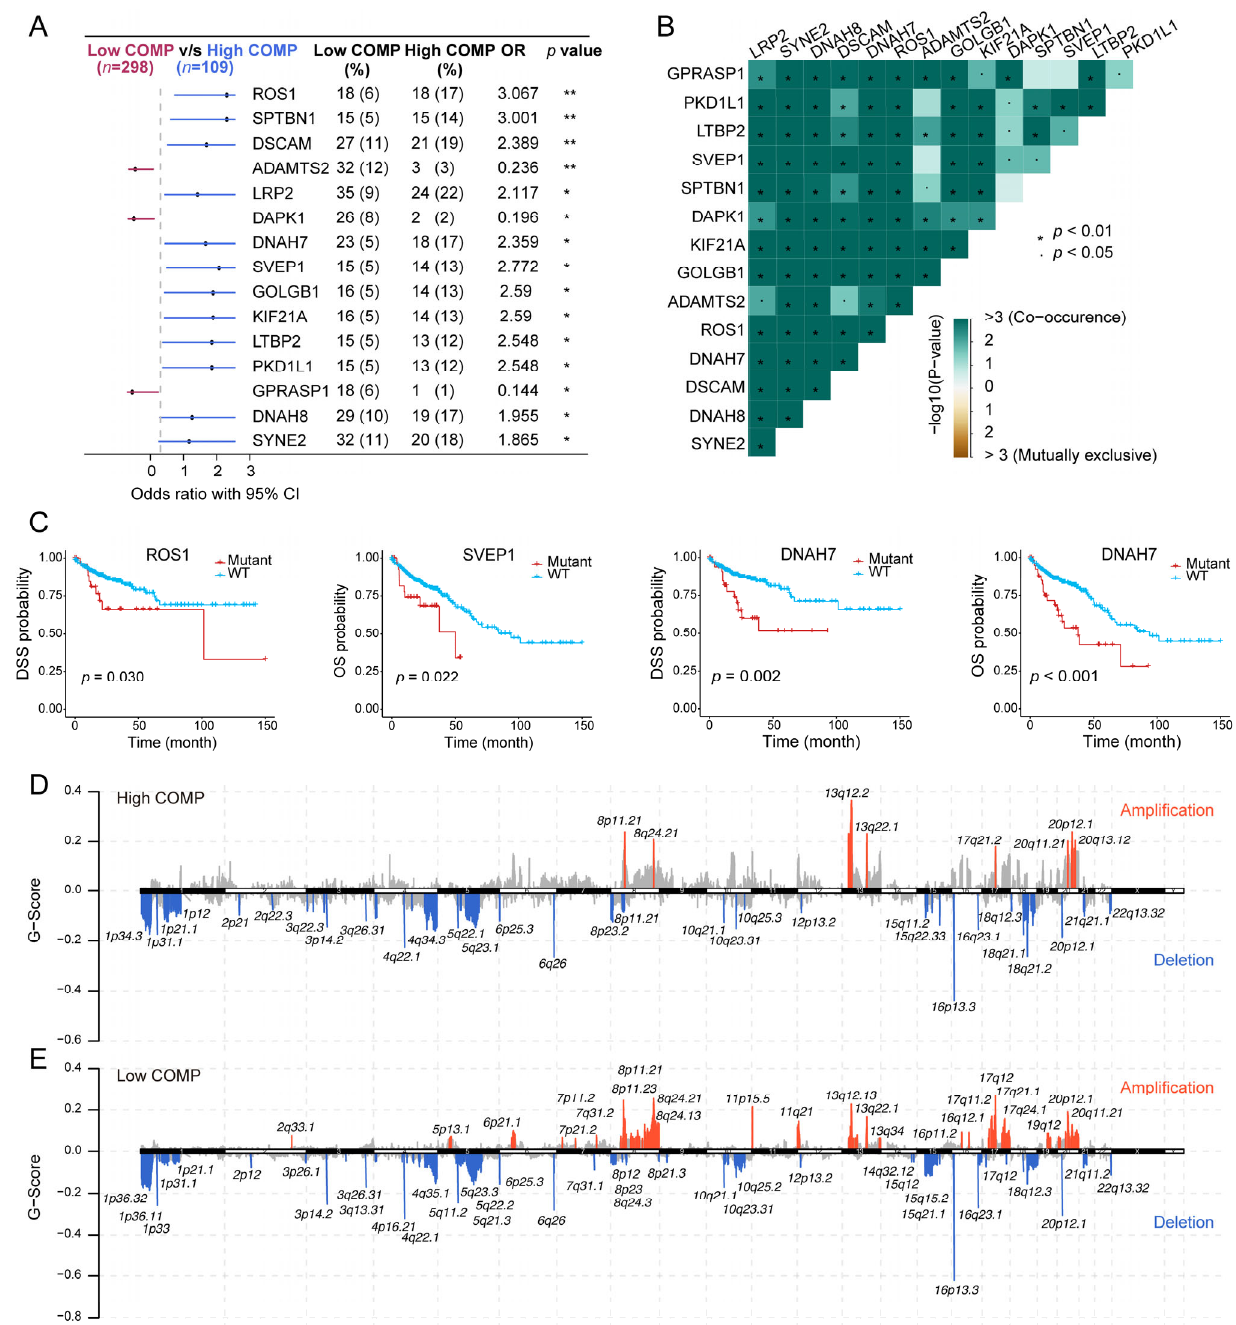
Figure 5. Correlation of COMP with the mutation landscape. ( A ) Forest plot of genes mutating differentially between low- and high-COMP expression subgroups; ( B ) Mutual exclusivity and co-occurrence analysis of genes mutating differentially between the two subgroups; ( C ) K–M curves display that patients with ROS1, SVEP1, and DNAH7 mutations had a poor prognosis; ( D , E ) Comparison of amplification and deletion of copy numbers in high- and low-COMP expression subgroups.